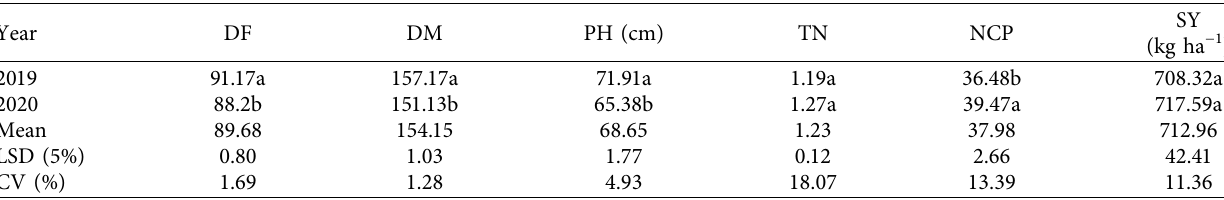
Table 4: Combined mean performance of yield and yield-related traits of the linseed varieties over the two cropping seasons (2019 & 2020).